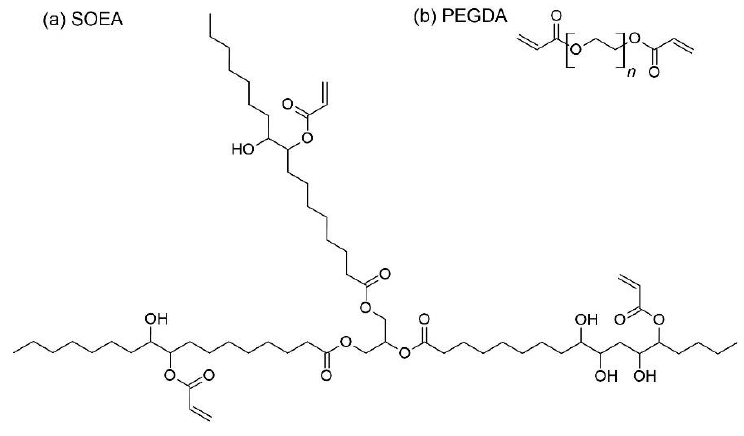
Figure 1. Structures of ( a ) SOEA and ( b )